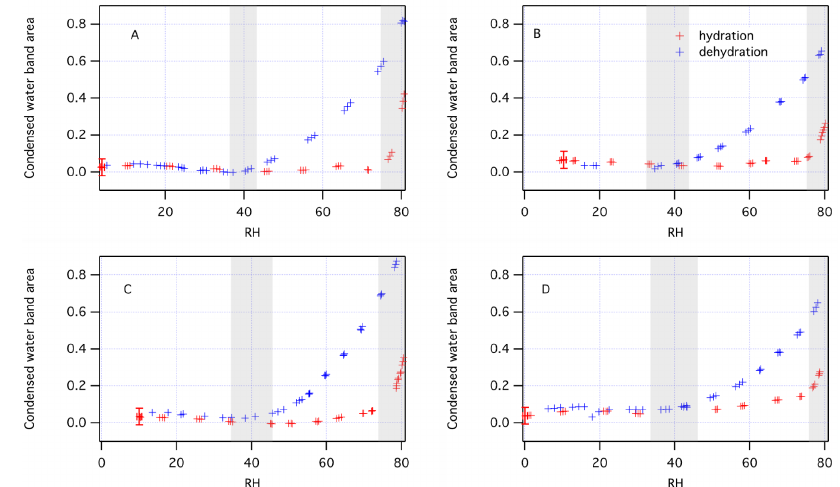
Figure 6. Deliquescence and efflorescence experiments on (NH 4 ) 2 SO 4 / 1,4-butanediol/water ternary mixtures of variable concentrations. (a) Pure ammonium sulfate. Note, efflorescence at ∼ 35% RH and deliquescence at ∼ 80% RH. (b) 1 : 3 1,4-butanediol / (NH 4 ) 2 SO 4 . Note, efflorescence at 35–40% RH and deliquescence at 80% RH. (c) 1 : 2 1,4-butanediol / (NH 4 ) 2 SO 4 . Note, efflorescence at 35–40% RH and deliquescence at 80% RH. (d) 1 : 1 1,4-butanediol / (NH 4 ) 2 SO 4 . Note, efflorescence at 35–40% RH and deliquescence at 80% RH.